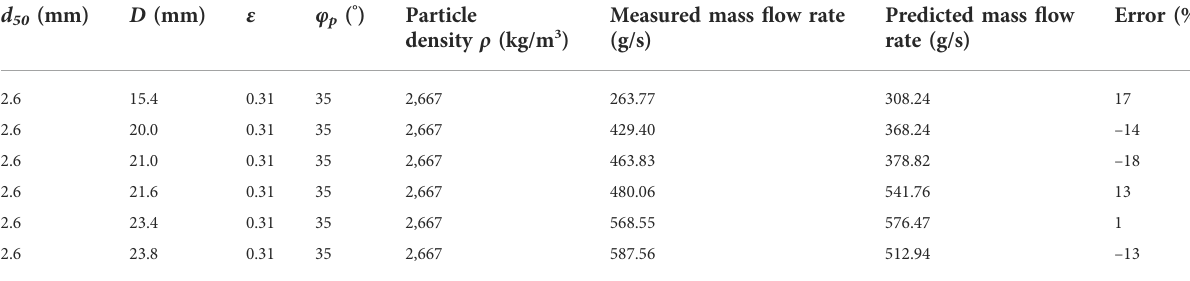
TABLE 2 Comparison of non-uniform granular fl ow rates between experimental and analytical results. d 50